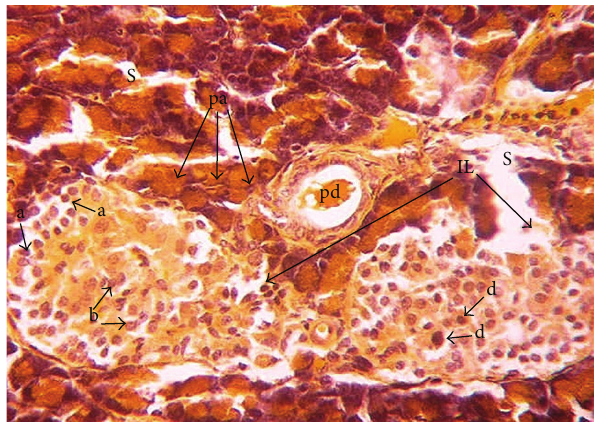
Figure 1: Photomicrograph of pancreas section of normal rat offspring after birth. The parenchyma is divided by septa (s) into pancreatic acini (pa) and pancreatic duct (pd). The endocrine portion of the pancreas consists of the islets of Langerhans (IL).